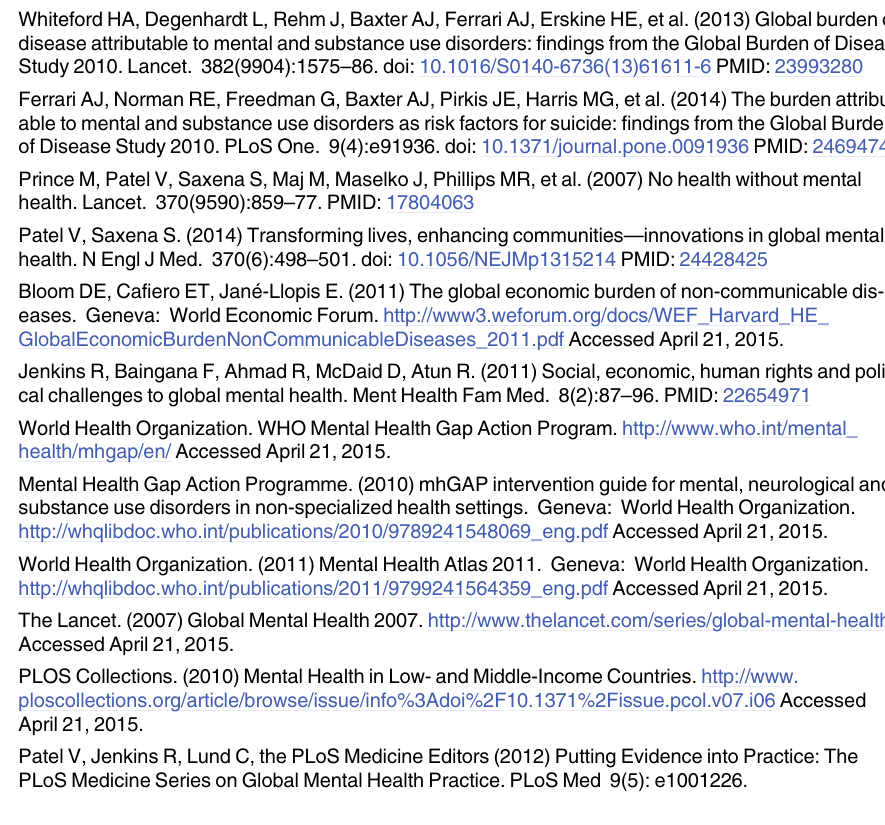
S4 Fig. Annual DAMH by income group, 2007 – 2013. LIC: low-income country; LMIC: lower-middle-income country; UMIC: upper-middle-income country. S5 Fig. Top ten recipients with the largest cumulative DAMH, 2007 – 2013. S1 Table. Keywords used to search for mental health projects in the Creditor Reporting System, 2007 –